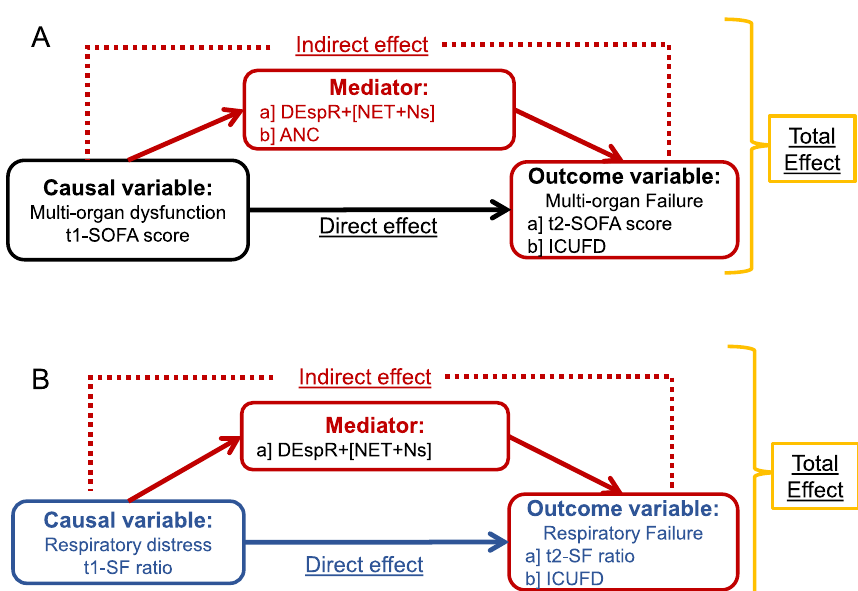
Fig. 3 Directed acylic graphs of causal hypotheses for mediation analysis of hypothesized mediators: DEspR in COVID‑19. A Hypothesis‑1: DEspR [NET Ns] mediate progression of multi‑organ dysfunction causal path between t1 (t1‑SOFA score) to + + multi‑organ failure (t‑2 SOFA score) or poor clinical outcomes (ICUFD). Alternative mediator tested: ANC, absolute neutrophil counts. B Hypothesis‑2: DEspR [NET Ns] mediate progression of respiratory distress at t1 (t1‑SF ratio) to respiratory failure at t2 (t2‑SF) or poor clinical outcomes (ICUFD). + + SOFA‑score, obtained without neurological component; ICUFD, ICU‑free days by day 28 with 0 for patients in the ICU > 28 days and competing risk of death